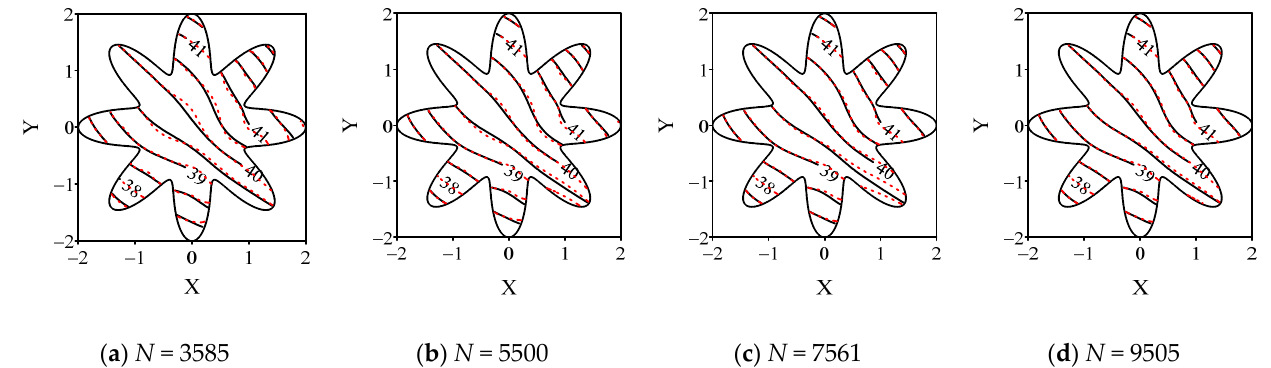
Figure 15. The comparison of numerical solutions of direct problem (solid curve) and inverse problem (dashed curve).